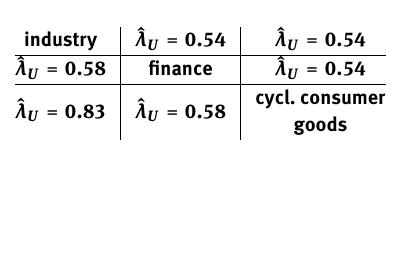
Table 4. Coefficients of upper tail dependency of ordinary Gumbel copula (upper triangle matrix) and HAC (lower triangle ma-